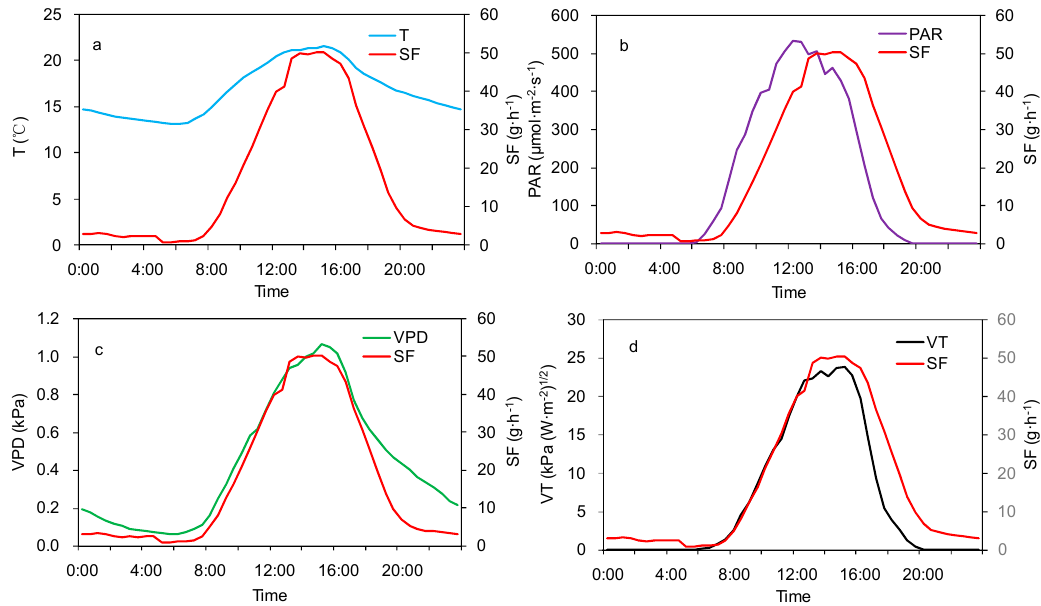
Figure 3. Diurnal variations in SF, ( a ) air temperature (T), ( b ) photosynthetically active radiation (PAR), ( c ) vapor pressure deficit (VPD), and ( d ) variable of transpiration (VT) for the whole measuring period.